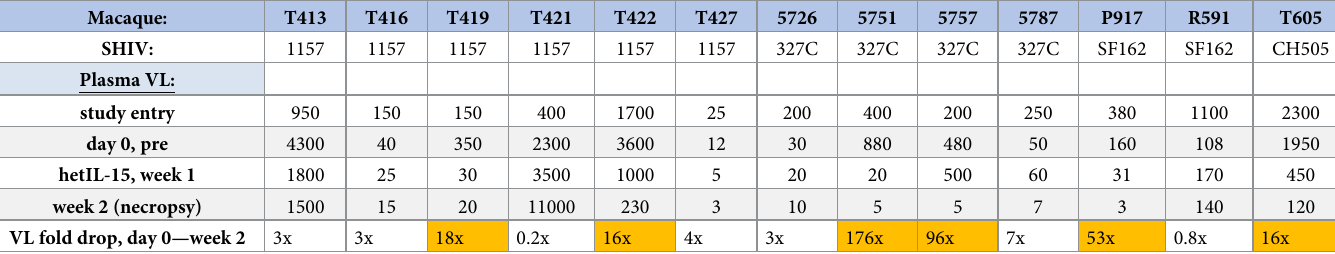
Table 2. Plasma viral load of 13 SHIV + macaques upon hetIL-15 treatment.